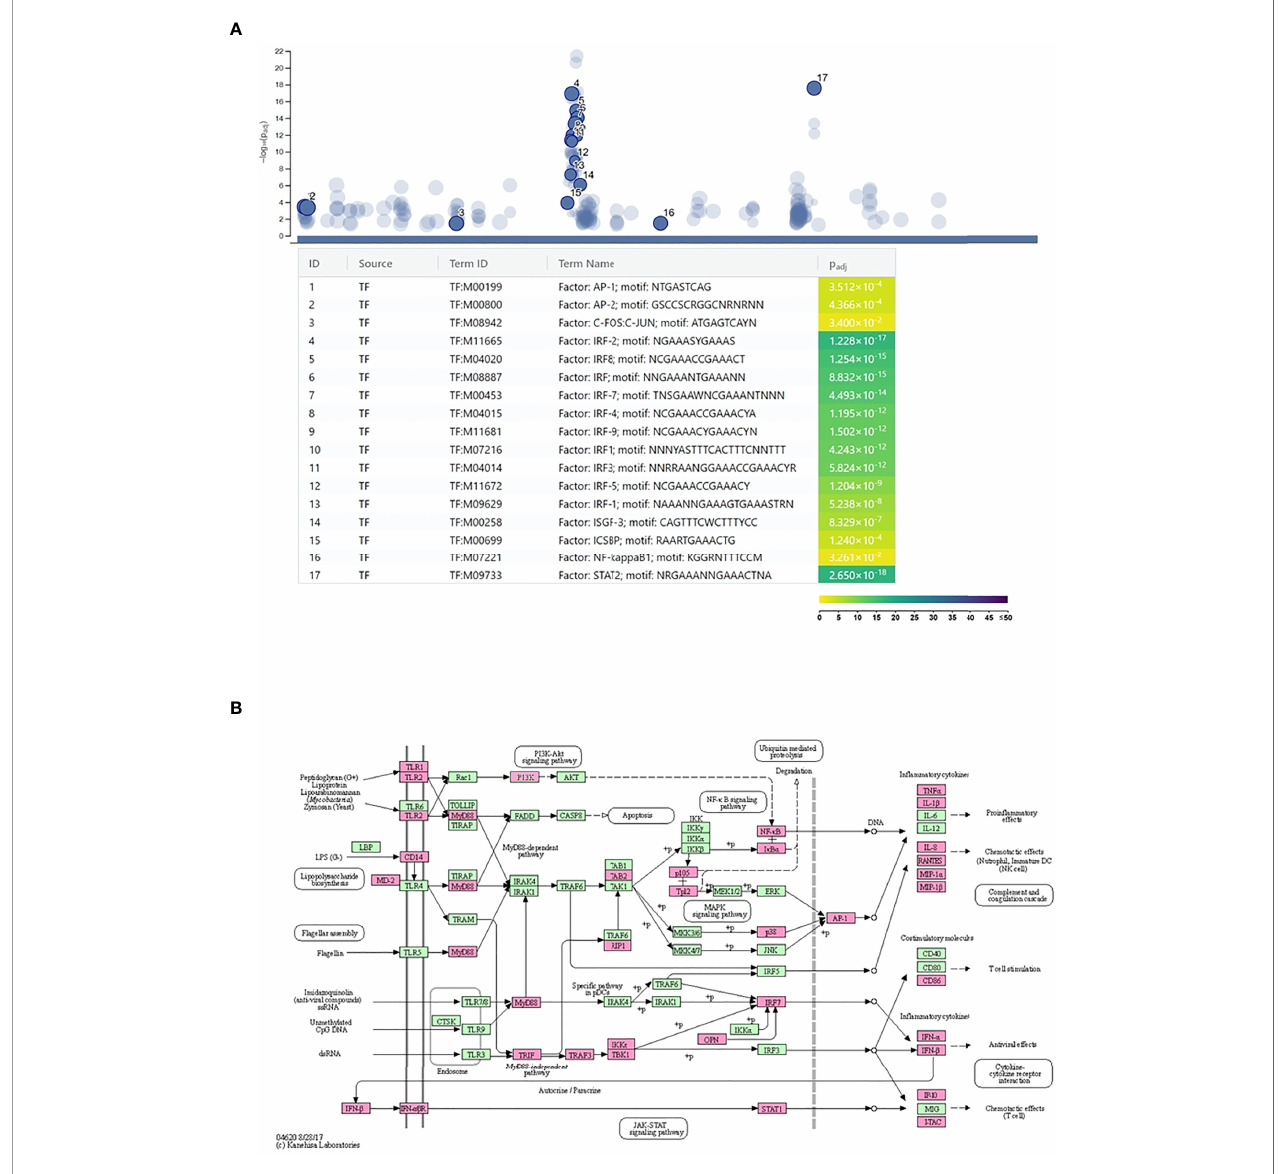
FIGURE 3 | Regulation of Chlamydia trachomatis infection-induced neutrophil gene expression. (A) Identi fi cation of the enriched transcription factor binding sites among the promoters of the C . trachomatis infection-induced genes. The names and signi fi cance levels of enrichment of selected transcription factors are shown. The color coding of transcription factor binding site enrichment P -values represents the signi fi cance level of enrichment. The color scale denotes the – log 10 P -value of enrichment. (B) C. trachomatis infection-induced genes mapped to the Kyoto Encyclopedia of Genes and Genomes Toll-like receptor signaling pathway. C. trachomatis infection-induced genes are shown in